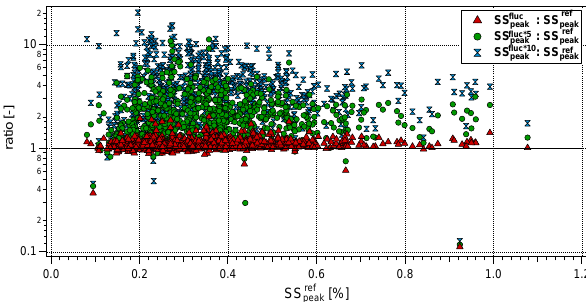
Figure 8. Ratio of modelled effective peak supersaturations applying small-scale fluctuations (obtained from the ultrasonic anemometer measurements) to the cooling rate, to the SS ref small-scale fluctuations are multiplied by 1 (SS fluc 5 (SS fluc · 5 ; green circles), and 10 (SS fluc · 10 peak